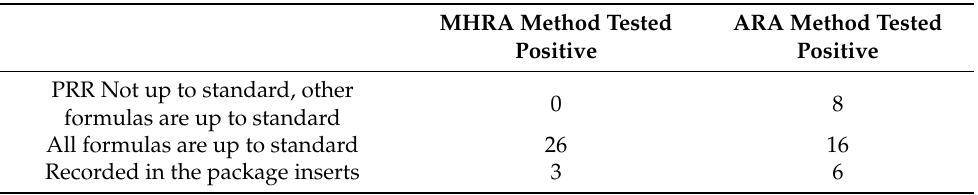
Table 7. Etimicin test